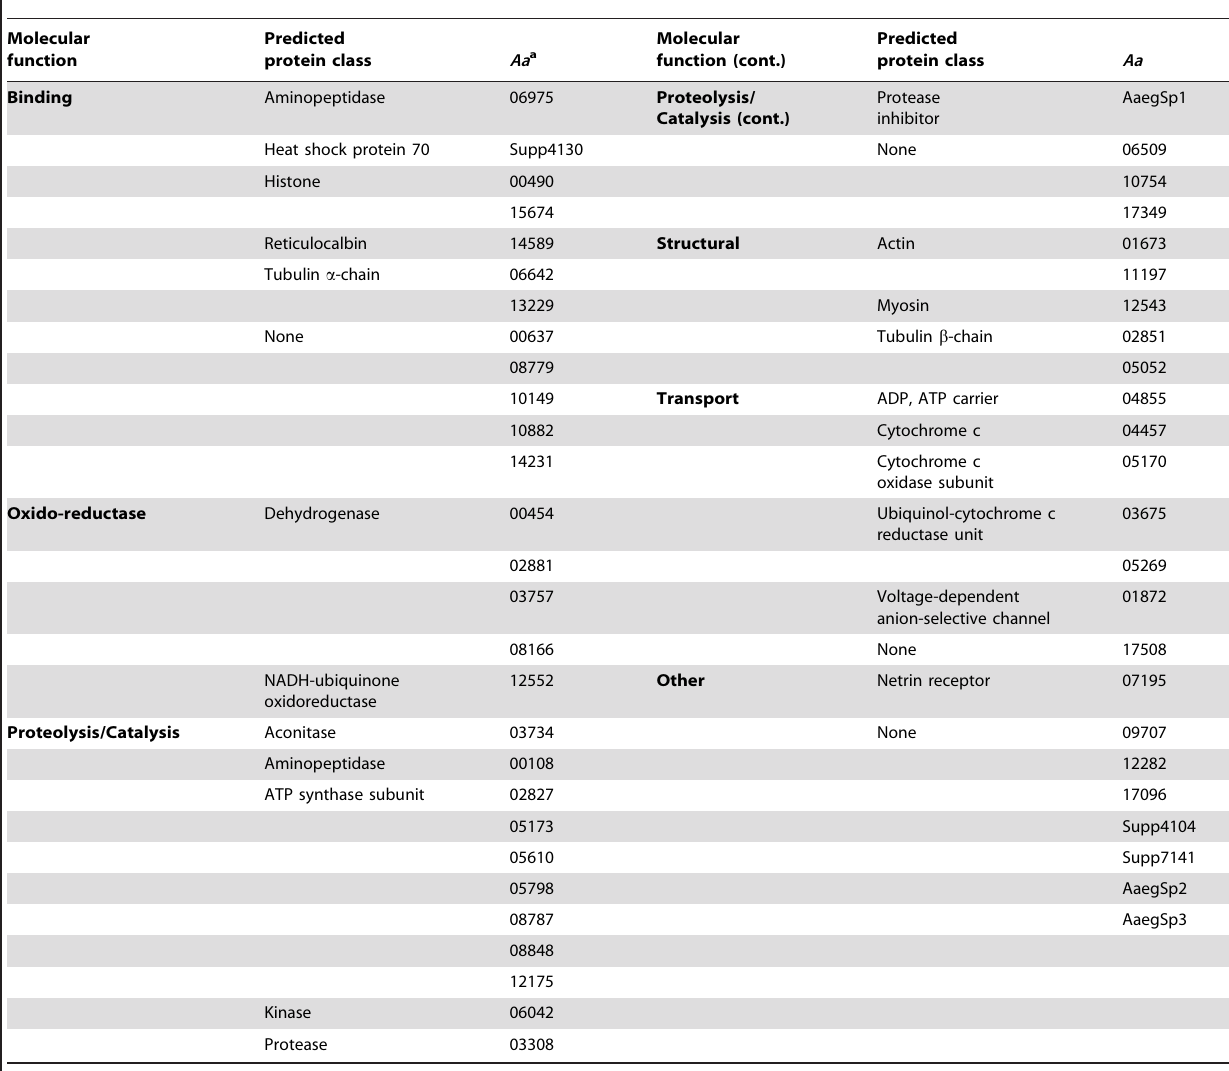
Table 2. Predicted sperm proteins transferred in Aedes aegypti ejaculate.